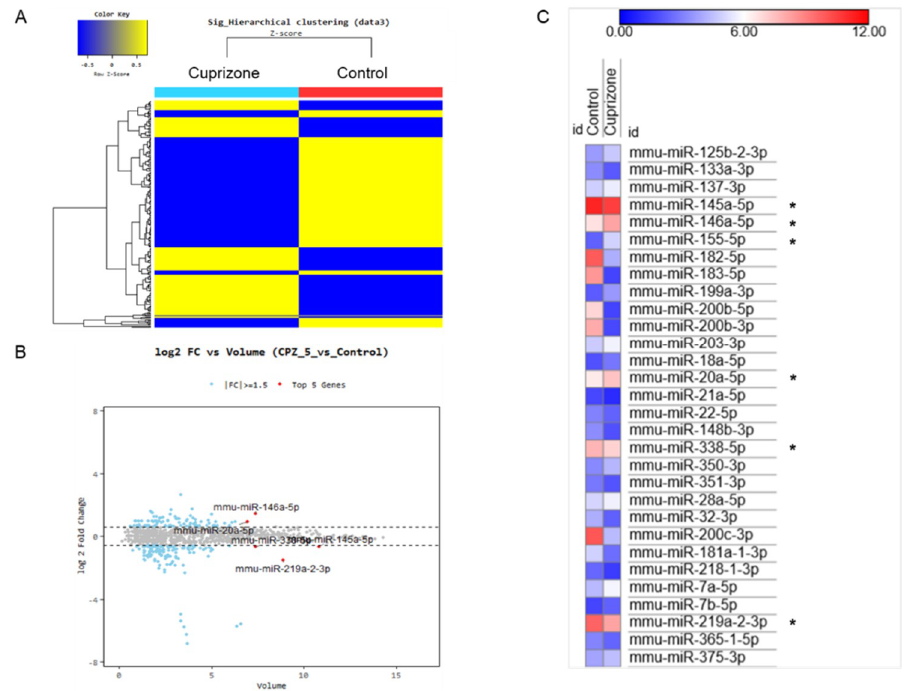
Figure 6. The miRNA expression analysis of cuprizone-fed mice and control mice. ( A ) Hierarchical clustering map of miRNA expression levels in cuprizone-fed mice versus control mice. Color key is Z-score (−0.5~0.5). ( B ) The graph shows the top five miRNAs evaluated using logarithmic fold change (log 2) vs. average expression in cuprizone-fed mice compared with control mice. ( C ) The expression heatmap shows miRNA expression changes (color key is expression score, 0–12), including the top five miRNAs (*) using the MORPHEUS tutorial program.